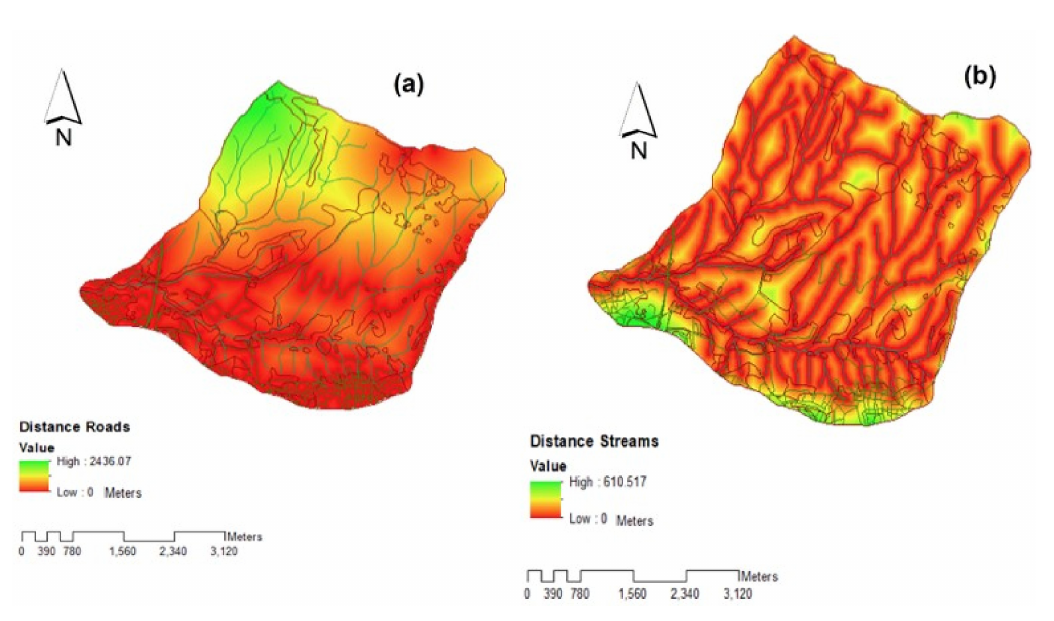
Figure 2. Euclidean distances from the Road Network ( a ) and Stream Network ( b